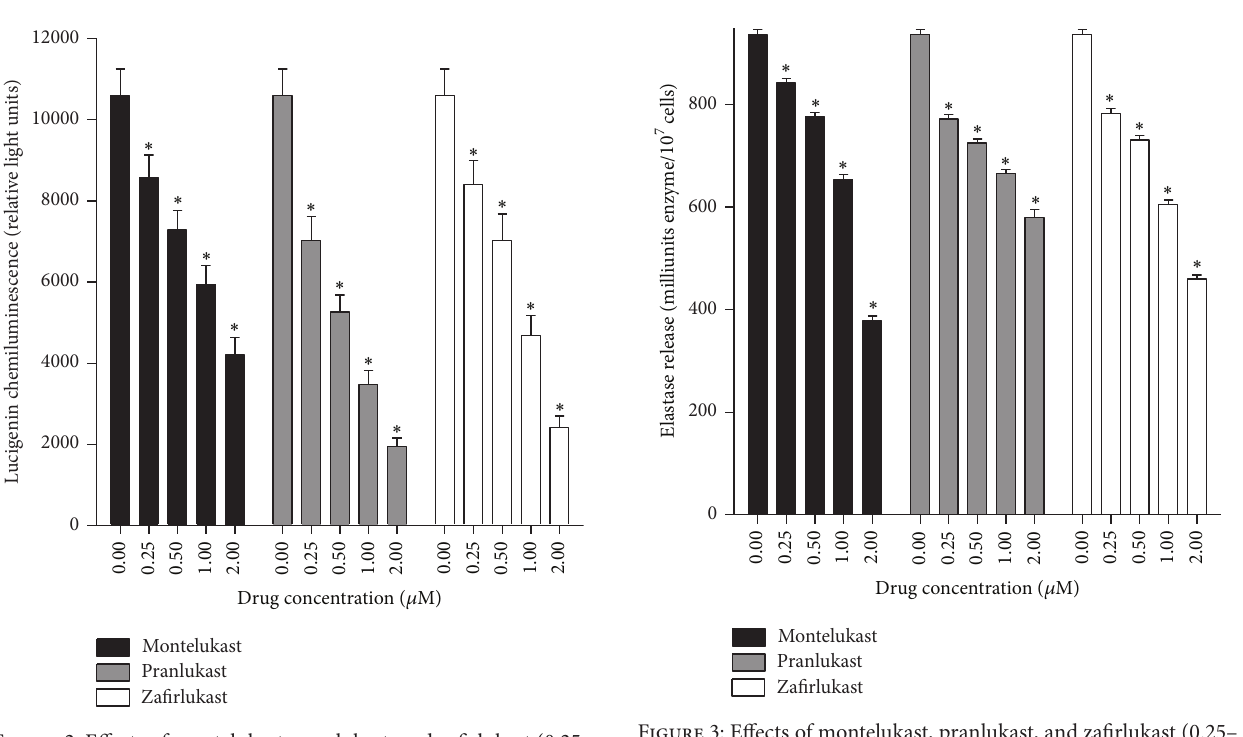
Figure 2: Effects of montelukast, pranlukast, and zafirlukast (0.25– 2 𝜇 M) on the lucigenin-enhanced chemiluminescence responses of neutrophils activated by N-formyl-L-methionyl-L-leucyl-L- phenylalanine (fMLP, 1 𝜇 M). The results are expressed as the mean peak chemiluminescence values in relative light units measured at 30–50 s after addition of fMLP and vertical lines show SEM ( 𝑛 = 6 with 2 replicates for each drug concentration and control system in each experiment). The absolute values for unstimulated neutrophils and for cells activated with fMLP in the absence of the drugs were 2099 ± 223 and 10594 ± 660 relative light units, respectively. ∗ 𝑃 < 0.05 for comparison with the fMLP-activated, drug-free control system.